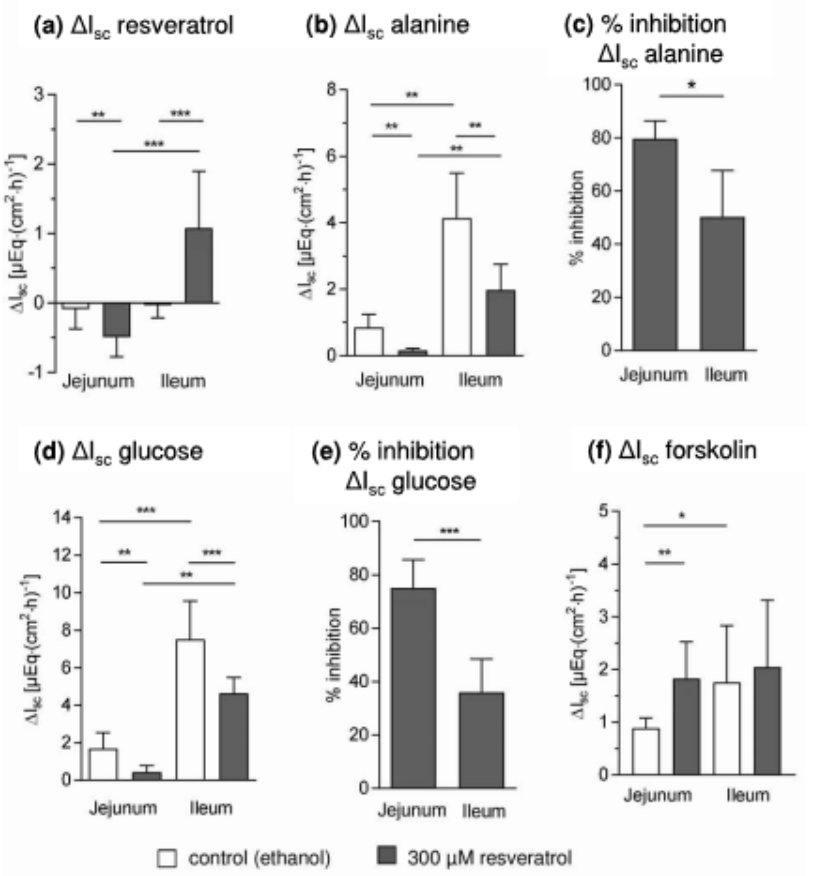
Figure 3. Effects of resveratrol on short circuit currents (I sc ) and respective changes ( ∆ I sc ) measured in Ussing chamber experiments with jejunal and ileal mucosae ( a ) ∆ I sc after the mucosal addition and 30 min of incubation with resveratrol (300 µ M) or solvent (20 µ L ethanol) ( b ) alanine-induced ∆ I sc (10 mM, mucosal) ( c ) percentage inhibition in ∆ I sc in relation to control chambers after the addition of alanine ( d ) glucose-induced ∆ I sc (10 mM, mucosal) ( e ) percentage inhibition in ∆ I sc in relation to control chambers after the addition of glucose ( f ) forskolin-induced ∆ I sc (0.01 mM, serosal). MW ± SD, n = 10 apart from ( b , c ) were n = 5, * p ≤ 0.05, ** p ≤ 0.01, *** p ≤ 0.001.